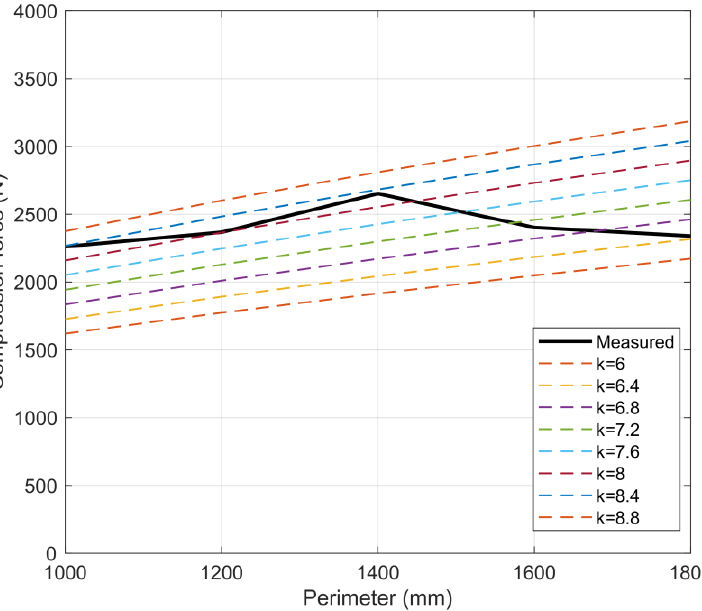
Figure 10. Iteration approximation of coefficient k for averages of BCT test results for uncut boxes of different sizes.